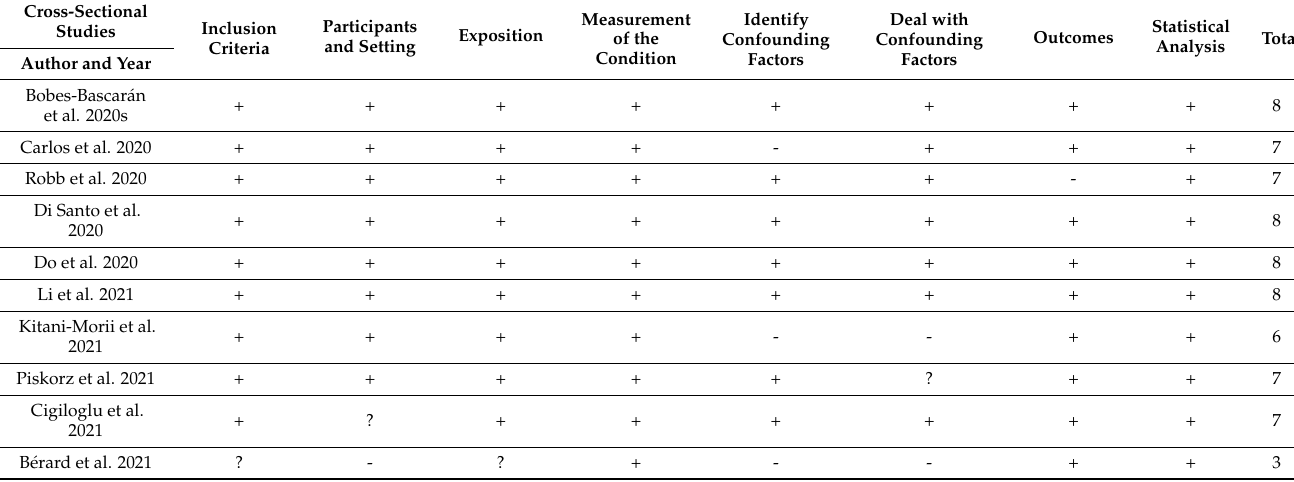
Table 3. Joanna Briggs Institute tool for cross-sectional studies.